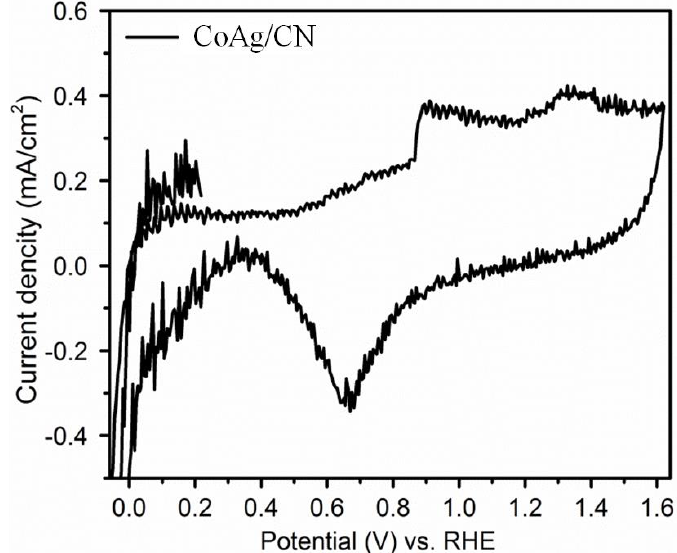
Figure 11. Cyclic voltammetry scan CoAg / CN of the ring electrode when the disc electrode was held at − 0.9 V versus RHE. Ring electrode was scanned between 0 and 1.3 V versus RHE. A constant rotation of 1500 rpm was applied in each case. Scan rate: 100mV s −1 .